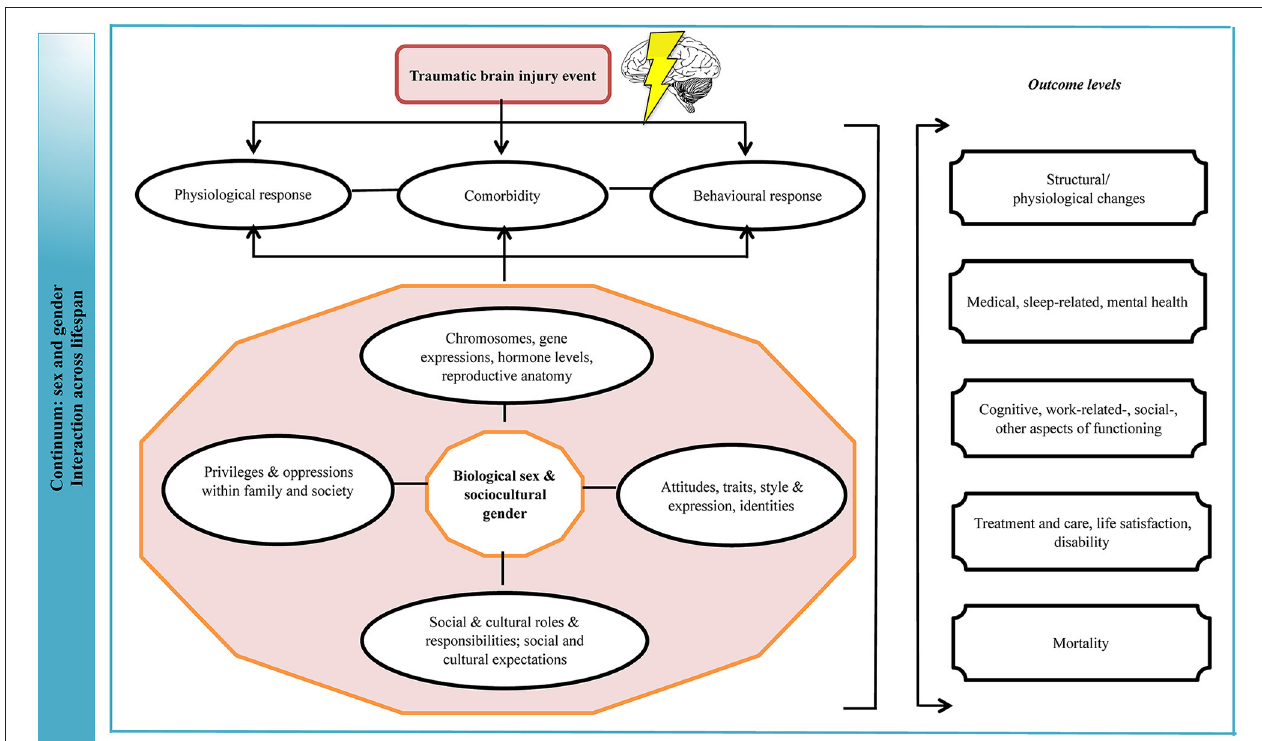
FIGURE 7 | Logic model of sex and gender effects on outcomes of TBI. The implications are that biological and behavioral vulnerability to injury and gender disparities in norms and role expectations make certain groups of male and female persons be prone to a more favorable or adverse outcome due to their unique interactions between biological, behavioral, sociocultural elements preceding, at the time of, and following the injury. TBI, traumatic brain injury. This figure was modified from a previously published framework